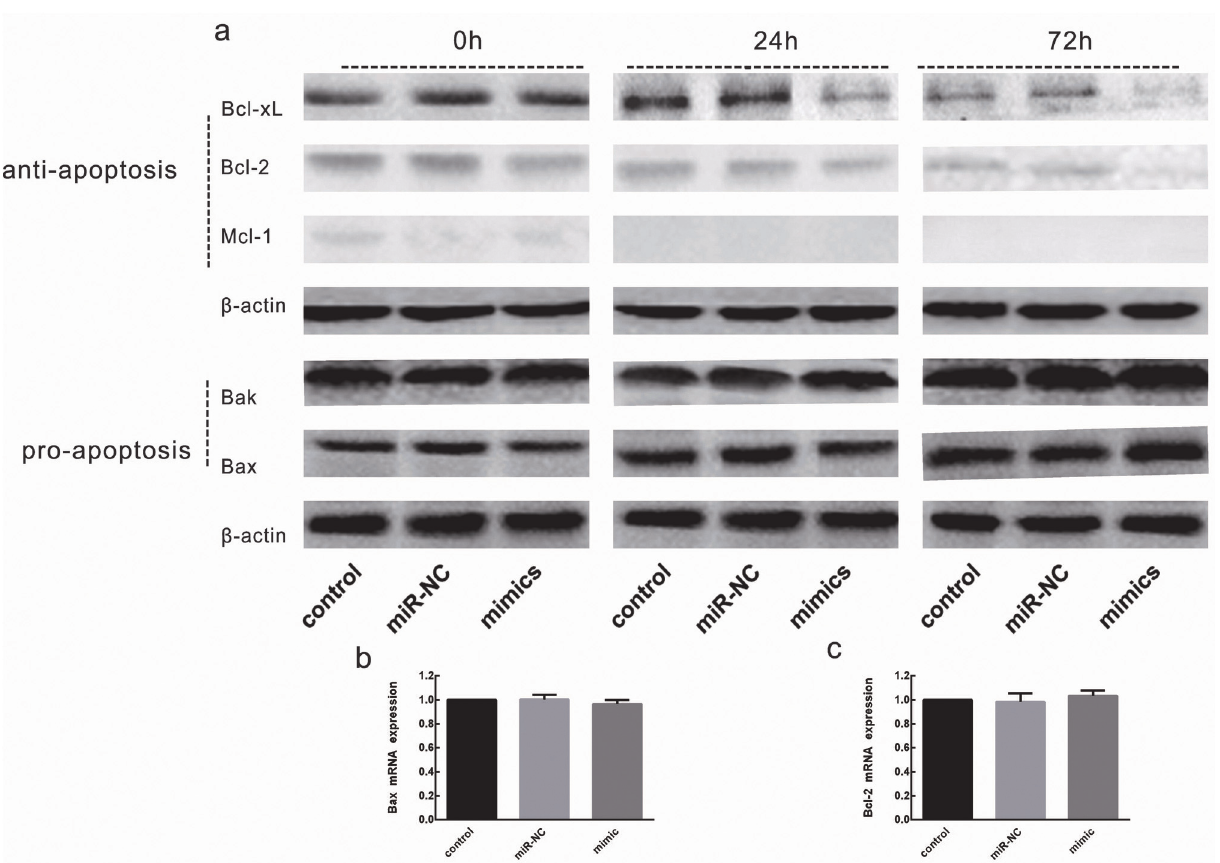
Fig 5. Expression of additional Bcl-2 family members after transfection. Lysates from washed platelets (20 μ g) were subjected to western blot analysis for expression of proteins. ( a ) Western blotting analysis is shown for untransfected platelets (control) and platelets transfected with miR-326 mimic or non- targeting negative control (miR-NC). Leukocyte-depleted apheresis platelets (LDPs) were cultured under standard blood banking conditions and harvested at the indicated times after transfection. Results are representative of 3 independent experiments. ( b, c ) The effect of miR-326 mimic transfection on Bcl-2 and Bak mRNA expression ( P > 0.05 vs.